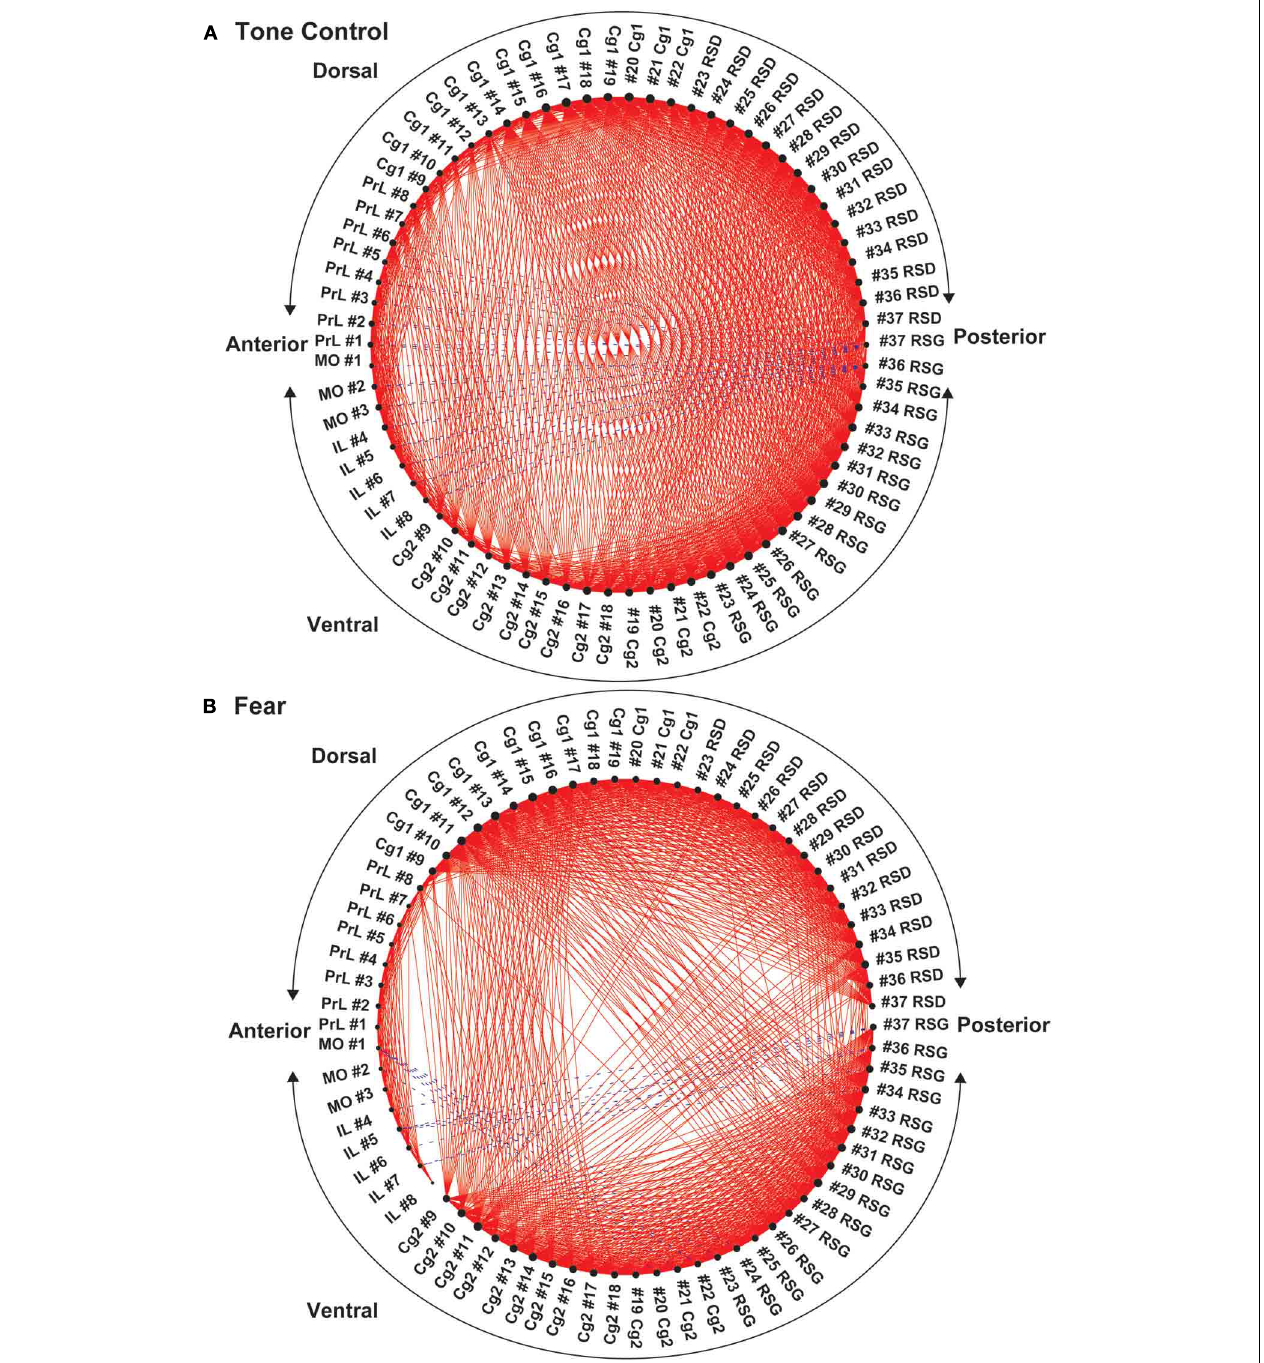
FIGURE 5 | Circular plot of graphs representing the functional networks of the cortical midline structures (CMS). (A) In control mice, functional segregation was observed along the anterior-posterior axis between the anterior aspect (PrL, MO, IL, anterior Cg1, and Cg 2) and posterior aspect (RSD, RSG, posterior Cg1, and Cg2) of the CMS. (B) In the fear-conditioned mice, functional connectivity between the dorsal and ventral aspect of the CMs was greatly reduced. In each circular plot, regions of interest (ROIs) representing the dorsal CMS are arranged in the upper half of the circle,